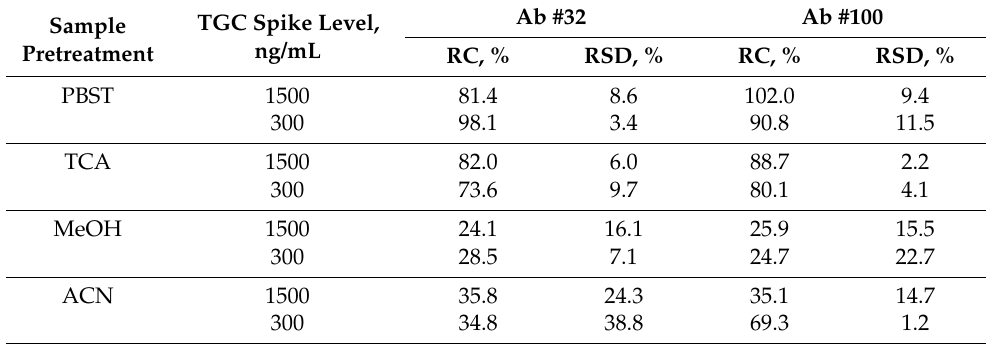
Table 3. Comparison of serum samples pretreatment approaches in recovery (RC) experiments.